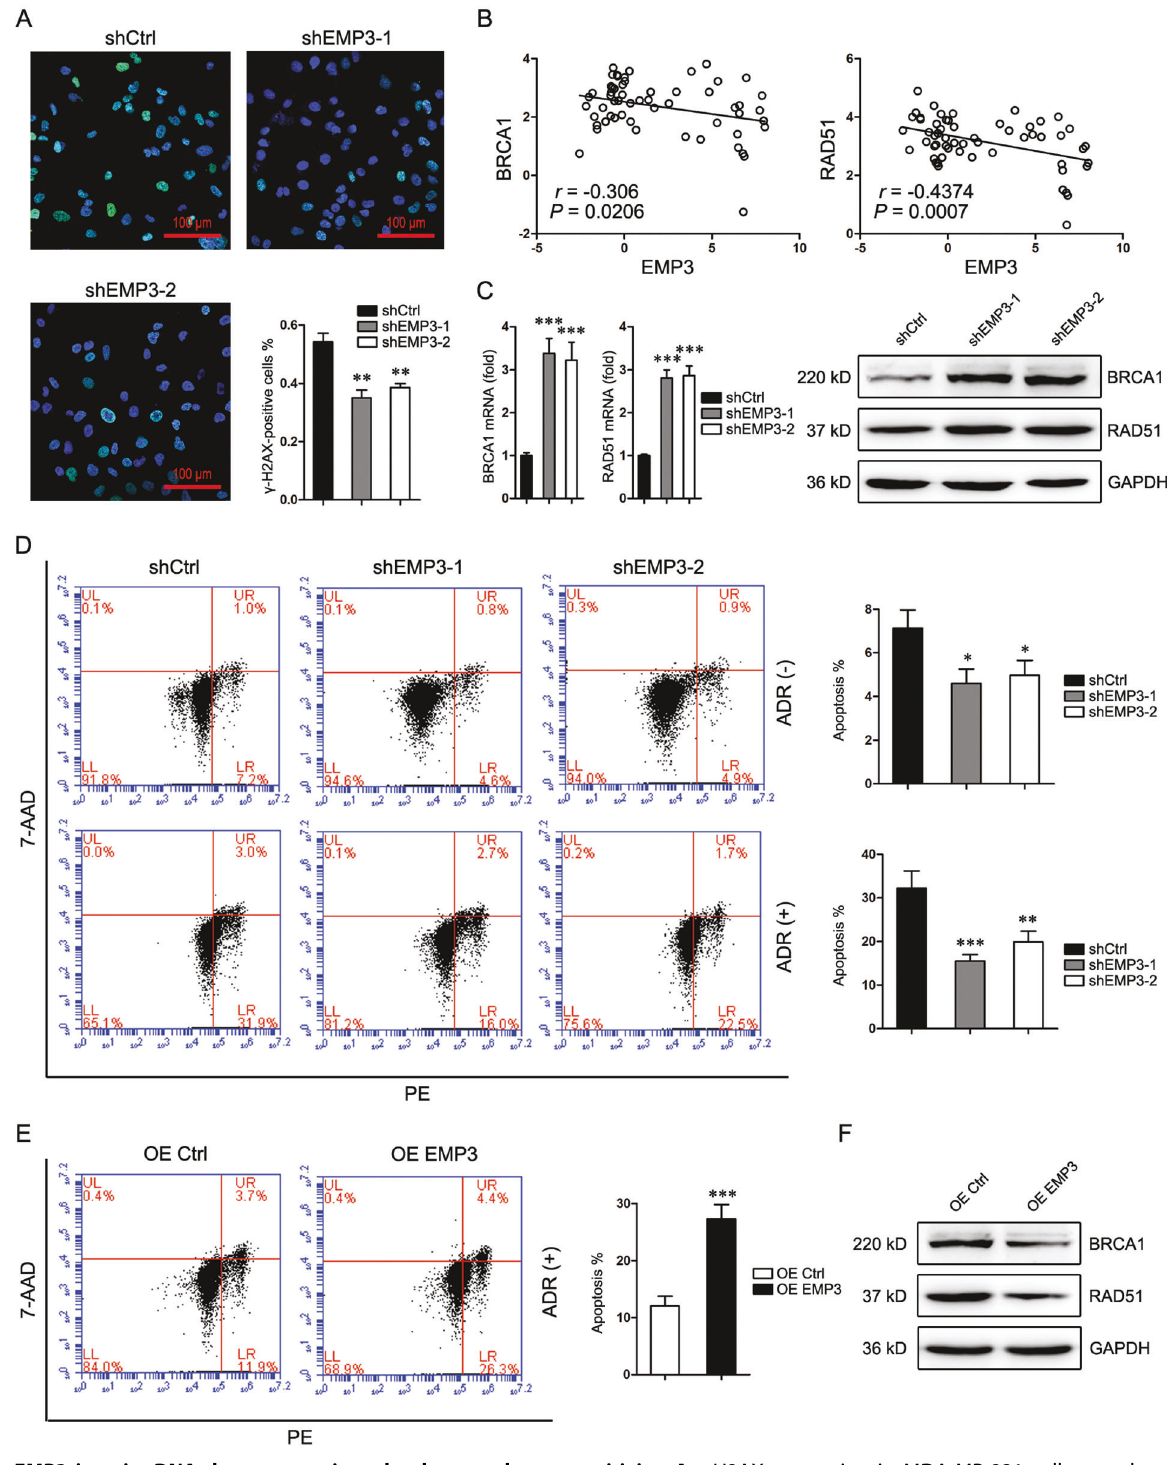
Fig. 3 EMP3 impairs DNA damage repair and enhances chemo-sensitivity. A γ -H2AX expression in MDA-MB-231 cells was detected by Immuno fl uorescence staining 48 h after treatment with ADR (500 nM). Mean ± SD, n = 3. ** P < 0.01, vs shCtrl. B CCLE database was interrogated for EMP3, BRCA1, and RAD51 expression. Correlation between two genes in a total of 57 breast cancer cell lines was analyzed by Pearson statistics. C BRCA1 and RAD51 expression in MDA-MB-231 cells were detected by western blot and real-time PCR. Mean ± SD, n = 3. *** P < 0.001, vs shCtrl. D Death of MDA-MB-231 cells was detected by fl ow cytometry 48 h after treatment with or without ADR (500 nM). Mean ± SD, n = 3. * P < 0.05, ** P < 0.01, *** P < 0.001, vs. shCtrl. E Death of MCF7 cells was detected by fl ow cytometry 48 h after treatment with ADR (500 nM). Mean ± SD, n = 3. *** P < 0.001, vs. OE Ctrl. F BRCA1 and RAD51 expression in MCF7 cells were detected by western